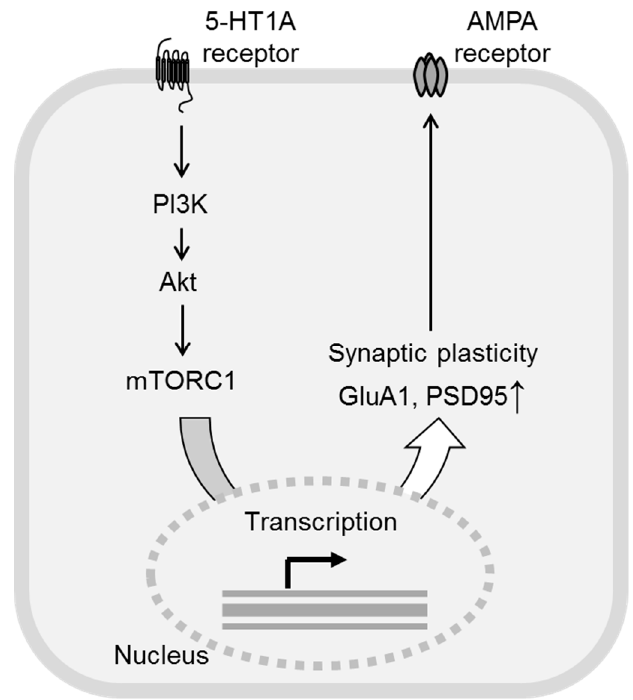
Figure 2. Proposed 5-HT 1A receptor-mediated signaling pathway through which mGlu2/3 receptor antagonists and ketamine exert their antidepressant effects. 5-HT release induced by mGlu2/3 receptor antagonists and ketamine as described in Figure 1 stimulates postsynaptic 5-HT 1A receptor in the medial prefrontal cortex (mPFC). 5-HT 1A receptor stimulation activates phosphoinositide-3-kinase (PI3K) and subsequently Akt, leading to activation of mechanistic target of rapamycin complex 1 (mTORC1) signaling. mTORC1 signaling increased synthesis of synaptic proteins such as GluA1 and PSD95, which induces synaptic plasticity. Increase in GluA1 synthesis persistently activates